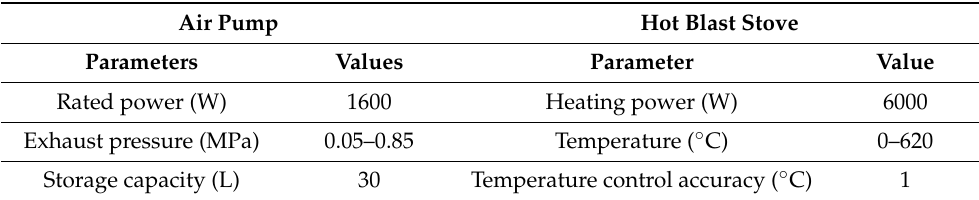
Table 1. Parameters of the air pump and hot blast stove.